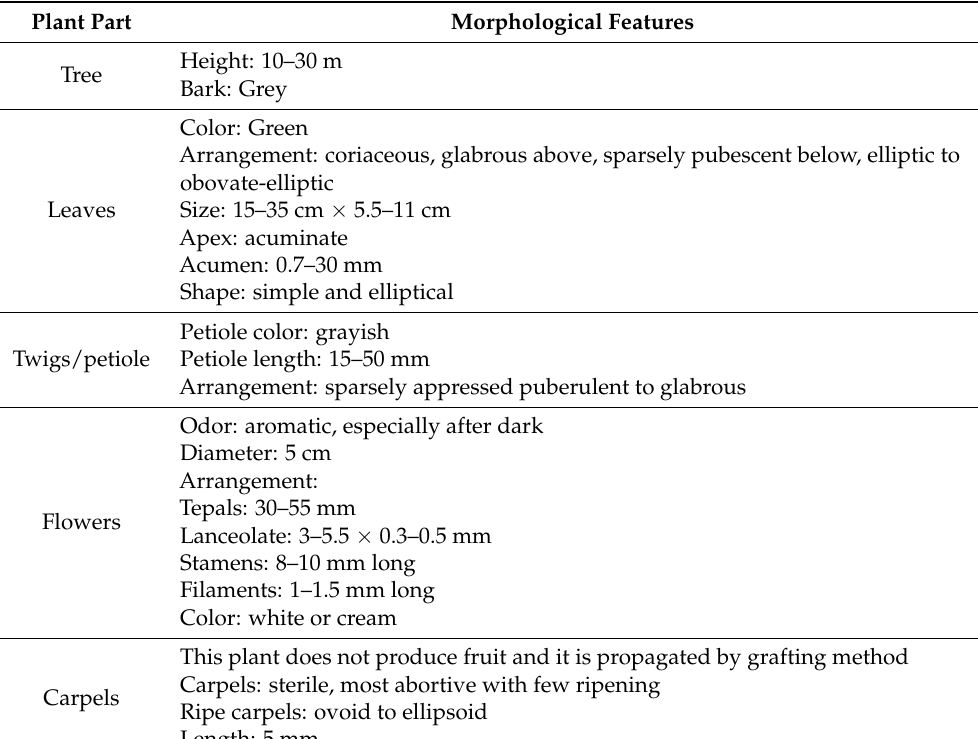
Table 1. Morphological features of Michelia alba ’s leaves, stems, flowers, fruits, and seeds with photo